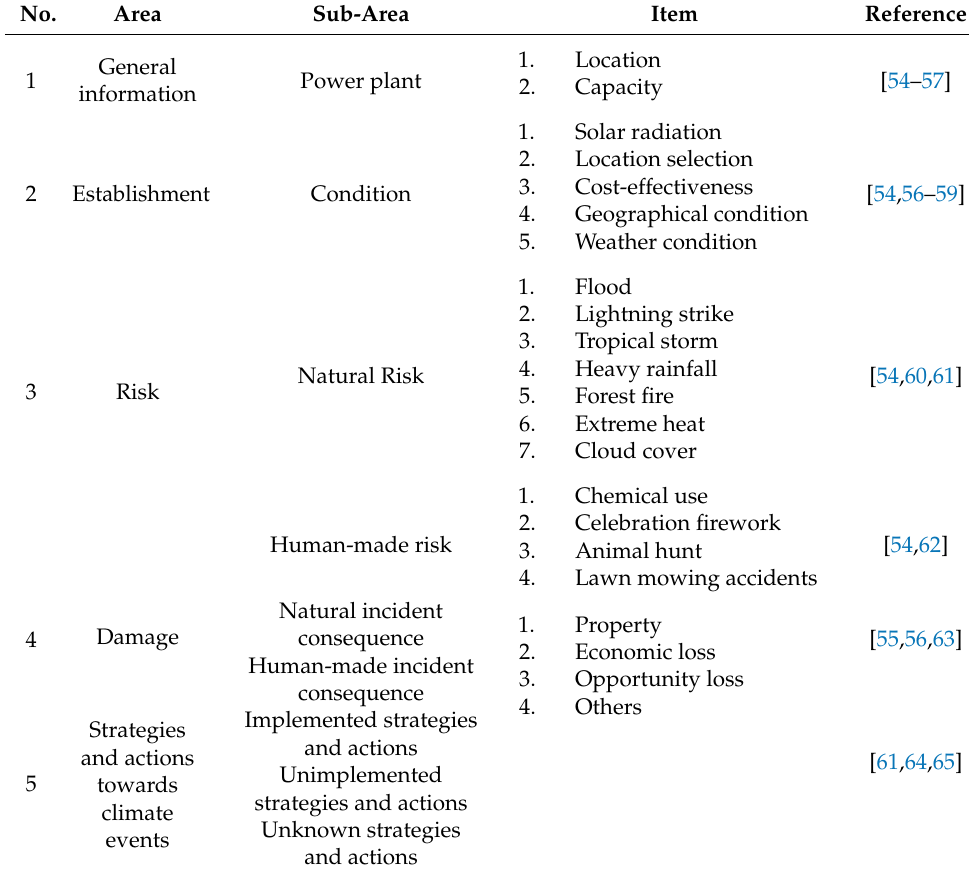
Table 3. Areas, sub-areas and supportive references for structured